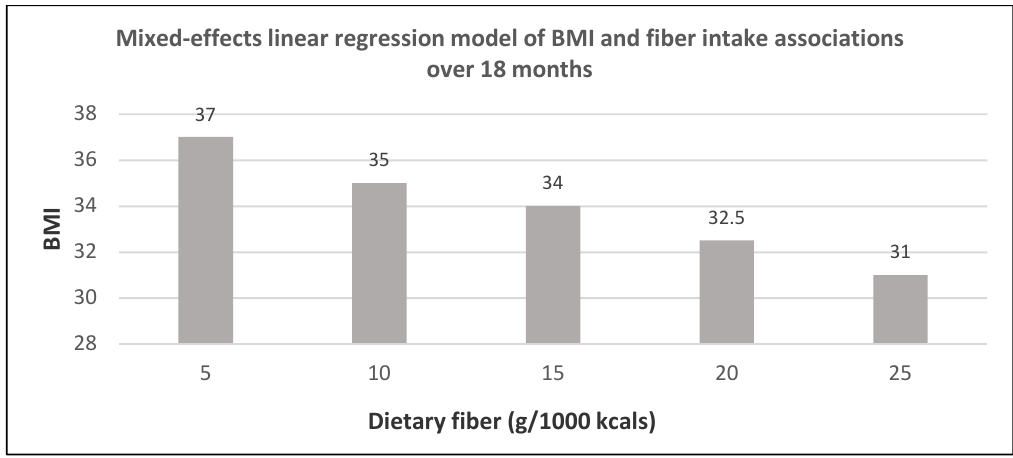
Figure 28. In a randomized weight loss and maintenance trial, increased fiber intake and BMI change estimated over 18 months (6-month intervention and 12 months of follow-up) in middle-aged obese African-American women ( p = 0.003) [82].